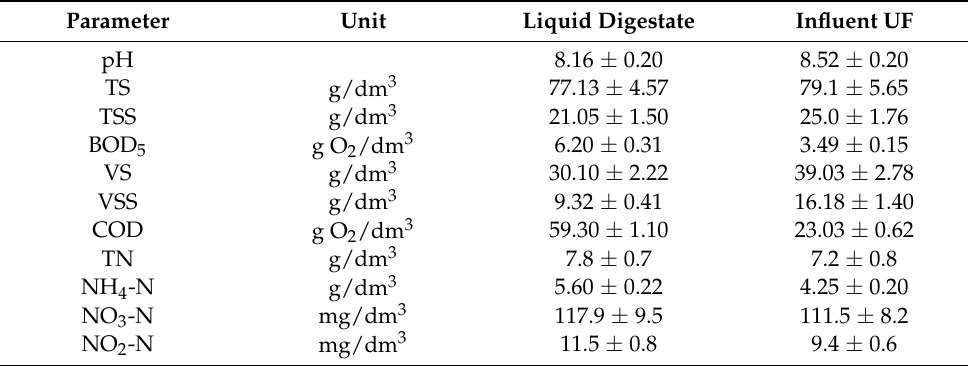
Table 3. Characteristics of liquid digestate and the influent of Ultrafiltration process.